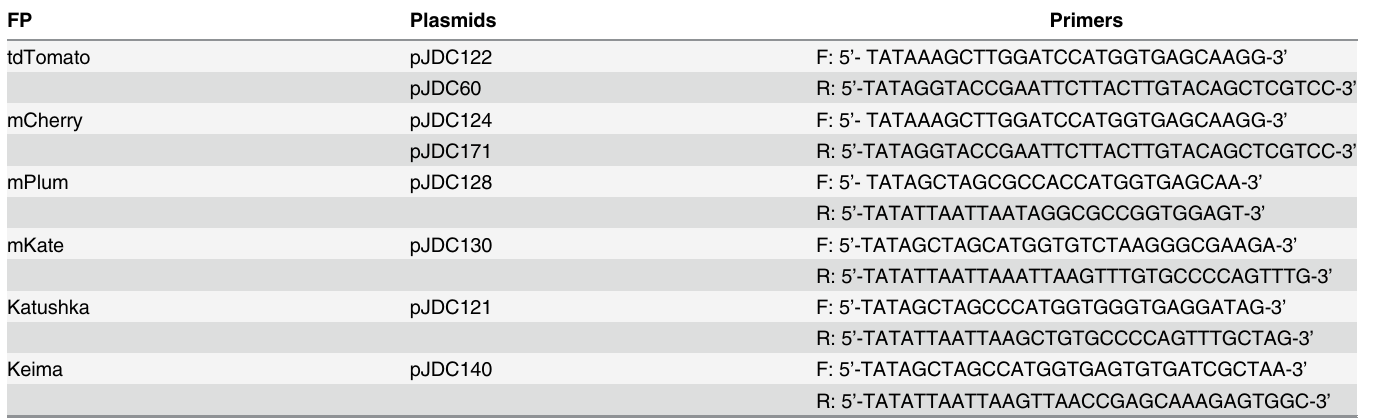
Table 1. Plasmids and primers.